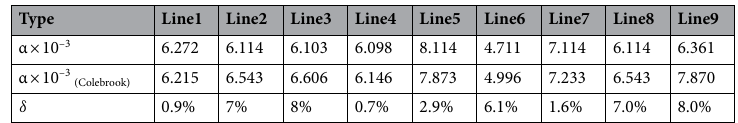
Table 5. Flow resistance factor prediction and numerical simulation